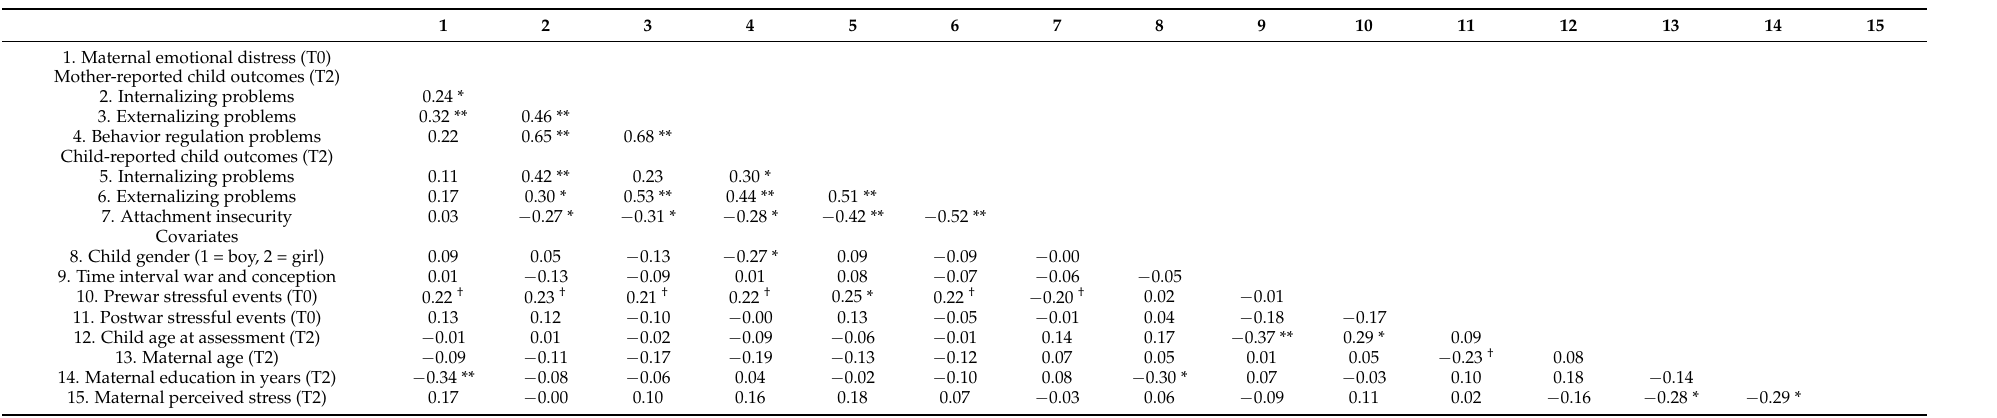
Table 3. Correlations between the study